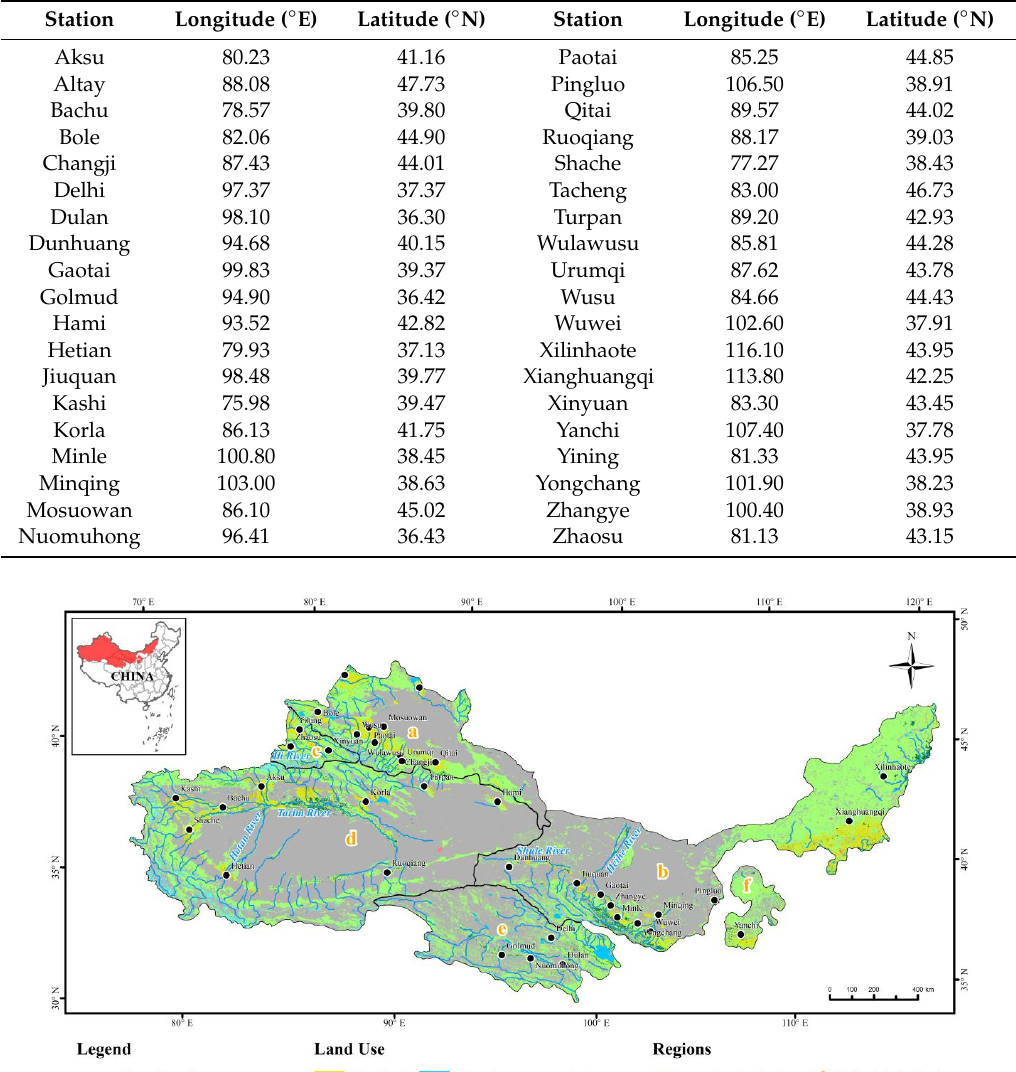
Table 1. Relative soil moisture measured at agrometeorological stations in a continental river basin area in China.